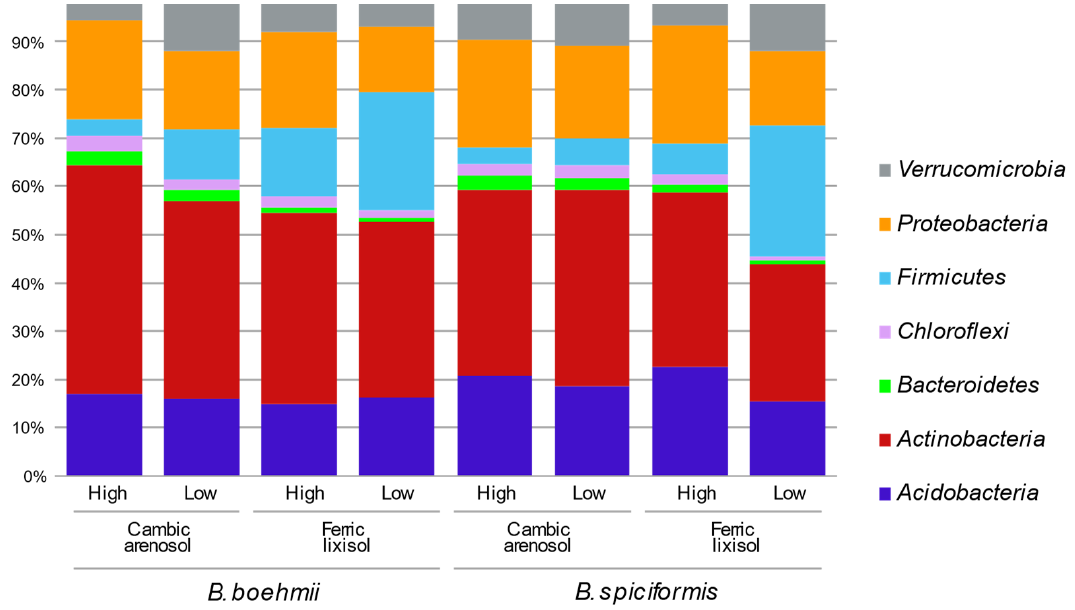
Figure 1. Relative abundance of bacterial phyla in the rhizosphere of Brachystegia spiciformis and Brachystegia boehmii sampled in cambic arenosol and ferric lixisol soils with low and high fire frequen- cies. Rare phyla, below 1% among all samples, or non-identified phyla were not included. Actinobacteria was the most frequent class across all samples (phylum Actinobacteria , 18.68 ± 0.06%), followed by Alphaproteobacteria (phylum Proteobacteria , 12.30 ± 0.03%) and Bacilli (phylum Firmicutes , 10.43 ± 0.03%; Supplementary Table S3). We found no changes in the abundance of Actinobacteria or Alphaproteobacteria across plant species, fire regime, or soil type (always p > 0.05). However, the abundance of Bacilli was significantly affected by the type of soil ( F = 1.775, p = 0.022) and fire regime ( F = 1.241, p = 0.027), being especially prevalent in ferric lixisol soils under LFF (23.73 ± 8.43% vs. 6.88 ± 1.22). Four abundant genera were a core element of the microbiome, having similar abun- dances across plant species, type of soil, or fire regime (always p > 0.05): Streptomyces (7.57 ± 0.06%), Gaiella (7.48 ± 0.02%), Chthoniobacter (6.63 ± 0.03%), and Bacillus (6.34 ± 0.07%) (Supplementary Table S4). Several bacterial genera, including Blastochloris , Aciditerrimonas , Azoarcus , Blastoca- tella , Dactylosporangium , Actinophytocola , and Nordella , were among the biomarkers de- tected in soils from HFF sites, while Amycolatopsis was more abundant in soils from LFF sites (Figure 2).